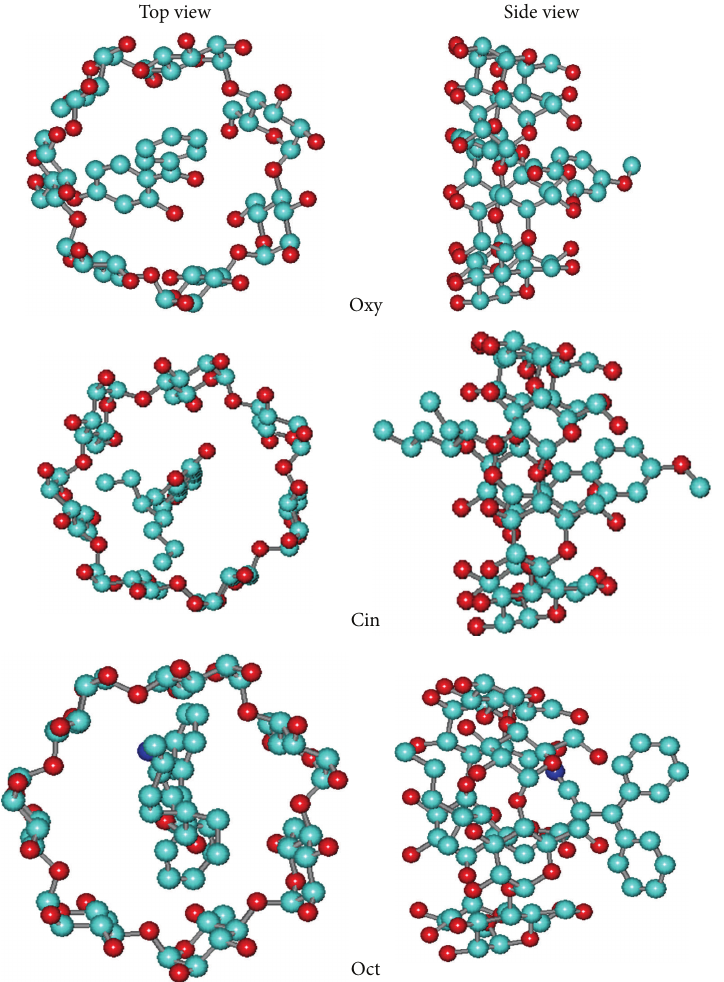
Figure 9: Side and top views for the proposed models of the energetically favored configurations of sunscreen agents : 𝛽 -CD inclusion